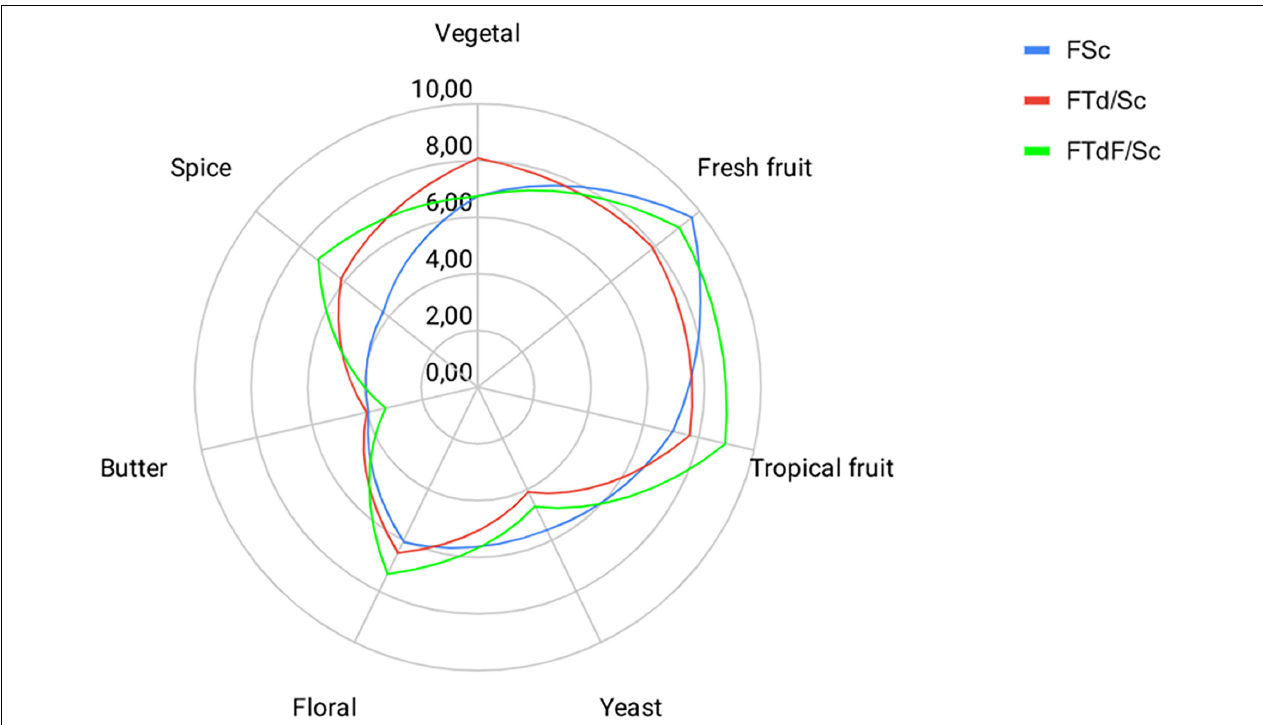
FIGURE 6 | Sensory profiles for Chardonnay wine obtained by pure fermentation (FSc) and co-inoculated fermentation FTd/Sc and